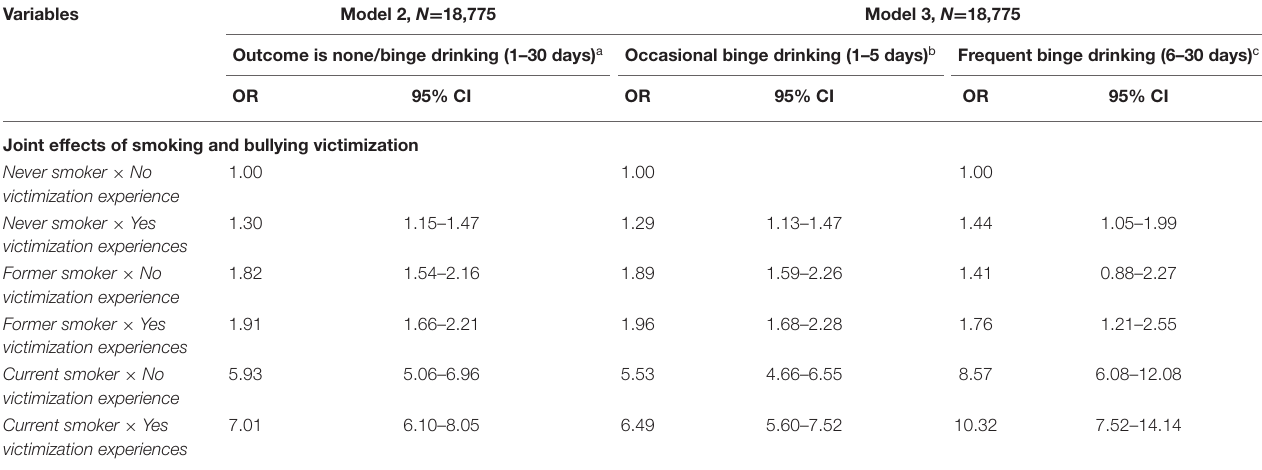
TABLE 5 | Multinomial logistic model for joint effects of smoking and bullying victimization on binge drinking among ever drinkers by adjustment for sociodemographic factors.